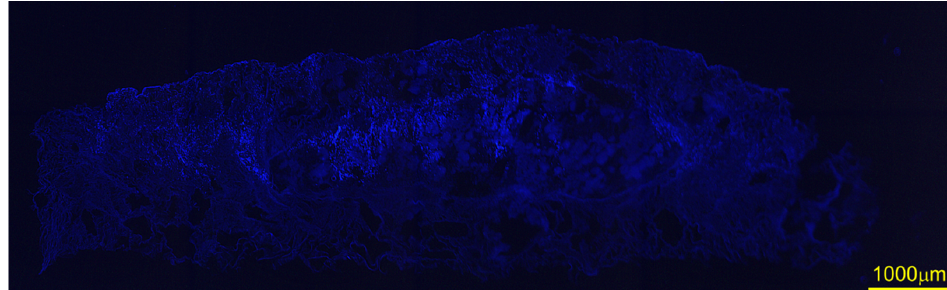
Figure 11. Images of DFAT seeded on α -TCP/GS and stained with DAPI. Scale bar is in 1000 µ